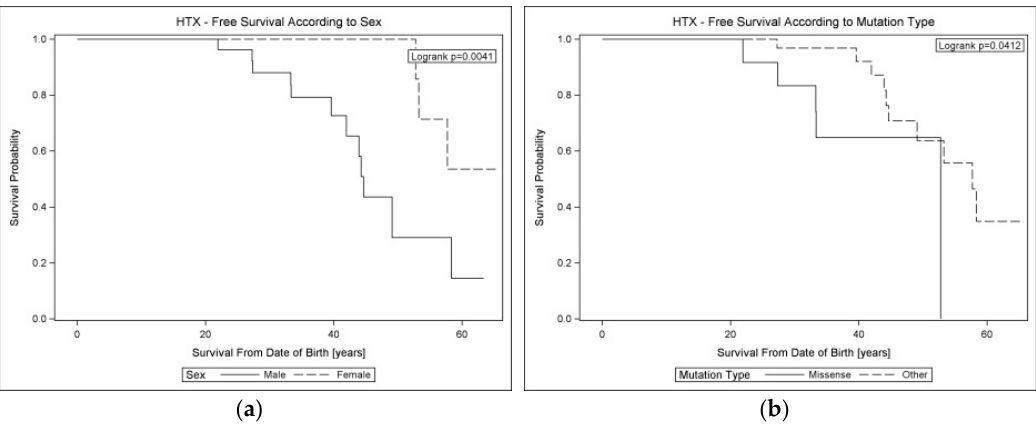
Figure 4. Kaplan–Meier lifelong HTX-free survival curves in cardiolaminopathy according to ( a ) sex and ( b ) mutation type. Legend: HTX: heart transplantation.